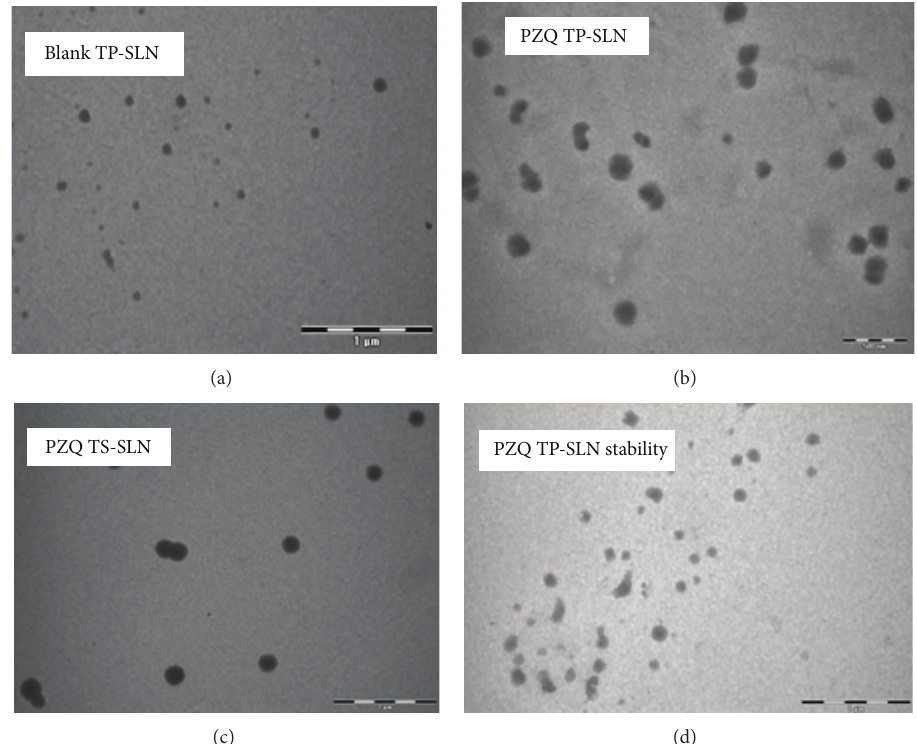
Figure 1: Transmission electron micrographs of different solid lipid nanoparticles. (a) Blank PZQ SLN, (b) PZQ TP-SLN, (c) PZQ TS-SLN, and (d) PZQ TP SLN stored at refrigerated temperatures for six